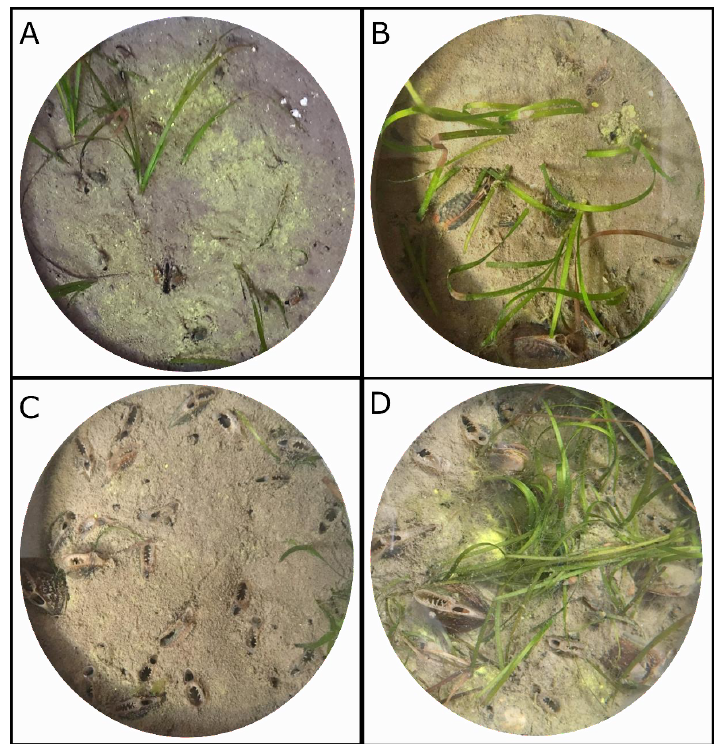
Figure 2. Photographs taken from above at the end of experiment of experimental cores from the low ( A ), medium ( B ), high ( C ) and very high ( D ) density treatments.